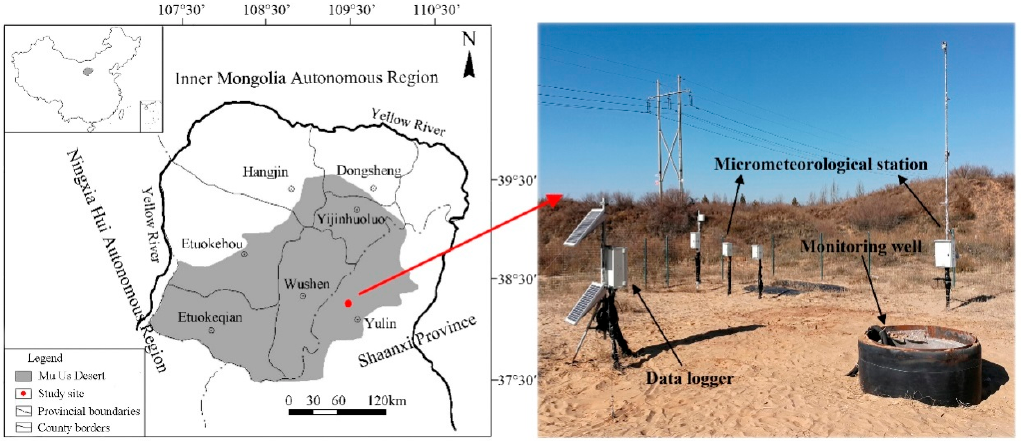
Figure 1. Location of the study site and the field instrumentation layout.